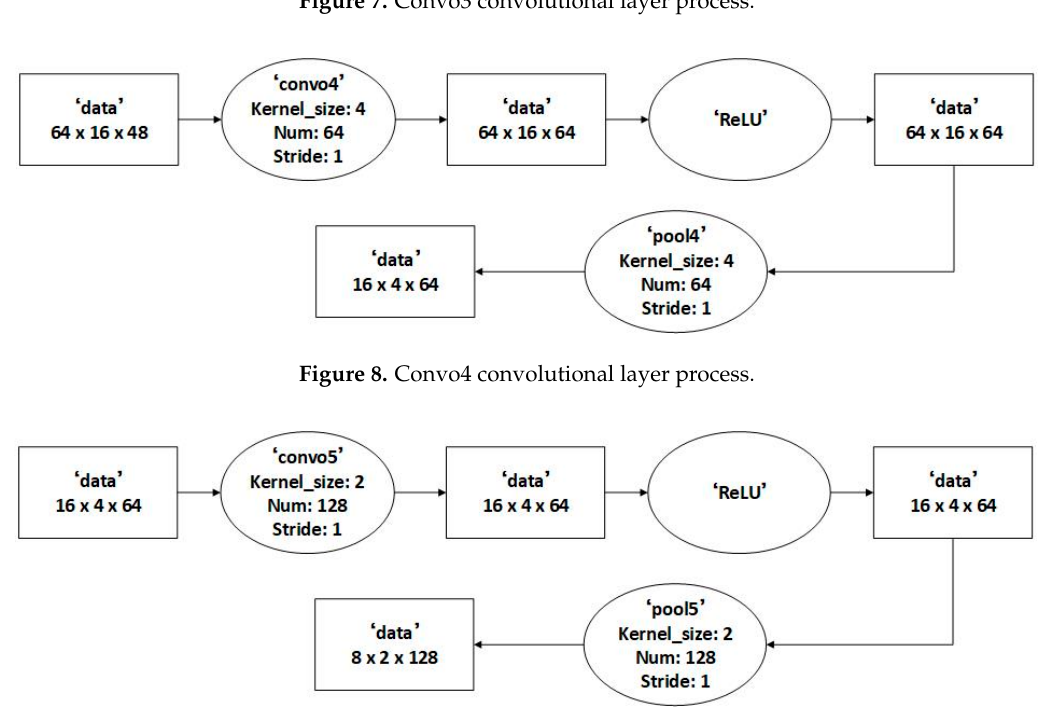
Figure 9. Convo4 convolutional layer